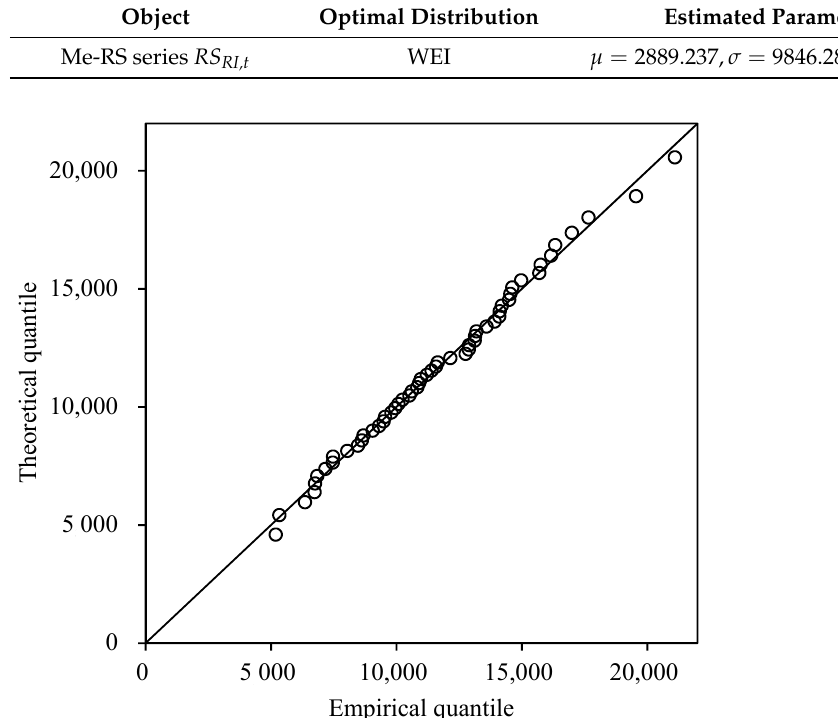
Figure 8. Q-Q plot of the theoretical and empirical quantiles for the Me-RS series of the JRB annual runoff.